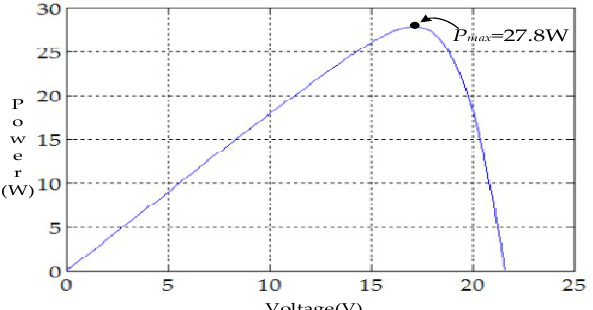
Figure 7. Simulation of P–V characteristic curve in Case 1.